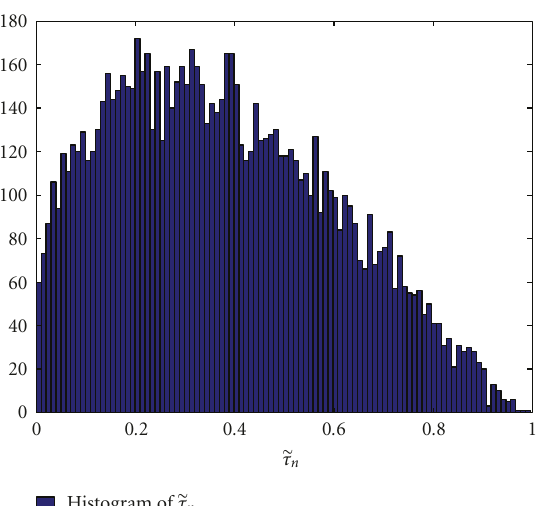
( τ ) = Prob( (cid:9) τ n ≤ τ ). Specifically, if F (cid:9) τ F (cid:9) τ n